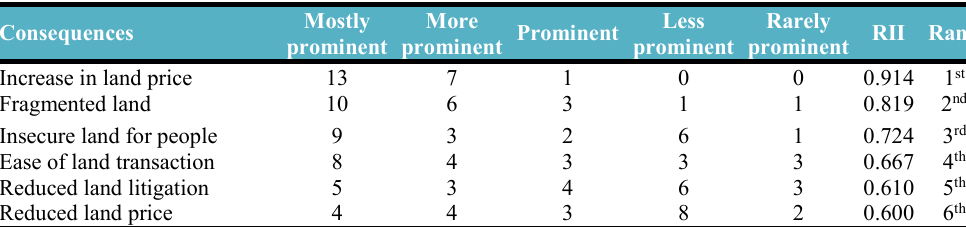
Table 7. Perceived Consequences of Land Speculation from Land